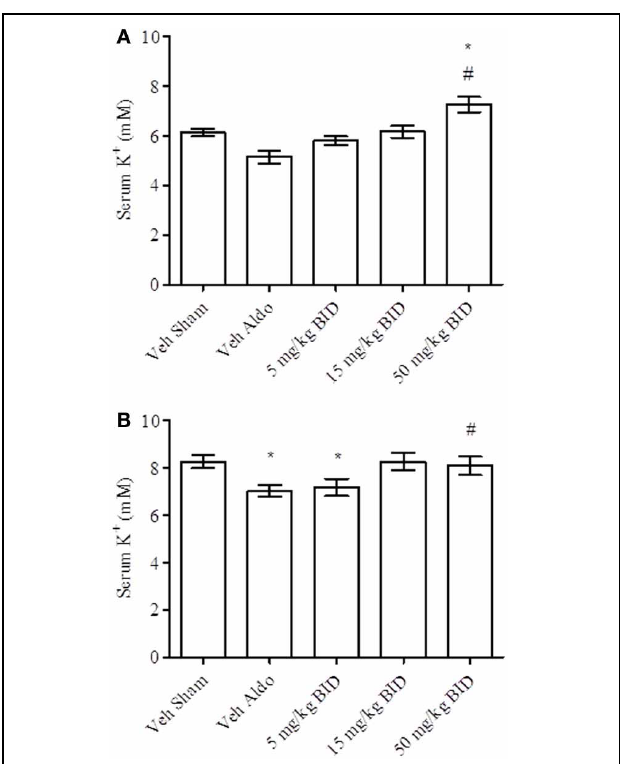
FIGURE 4 | Effect of PF-03882845 on serum K + on day 14 (A) and day 26 (B). Data are represented as mean ± standard error of the mean. See Materials and Methods for statistical analysis. ∗ Indicates a significant difference from the vehicle sham (Veh Sham) group; # Indicates a significant difference from the vehicle + aldosterone (Veh Aldo) group.